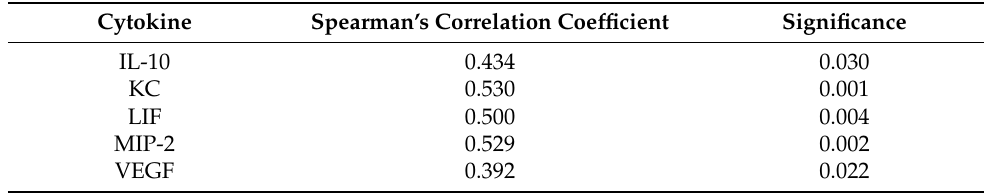
Table 8. Significant correlations between tumor volume and cytokine